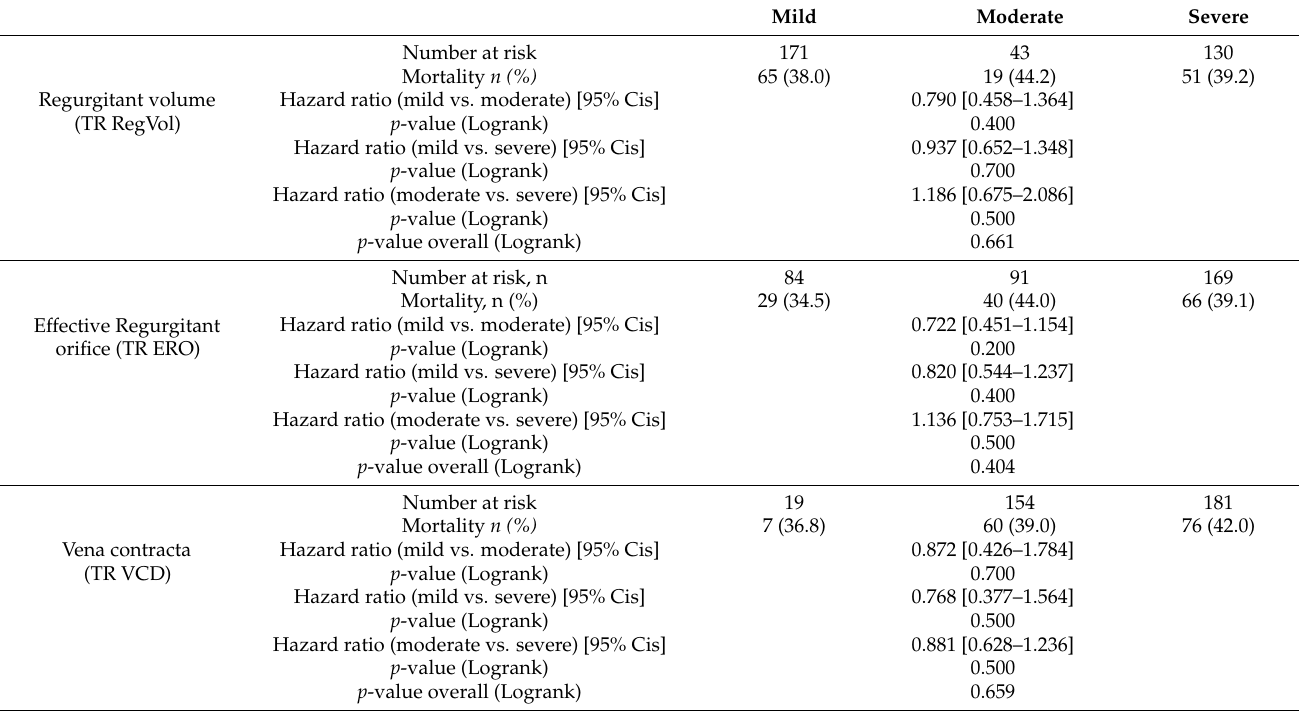
Table 4. Kaplan–Meier estimates for overall survival at 2 years for 4 different quantitative assessments of significant or disproportionate TR.